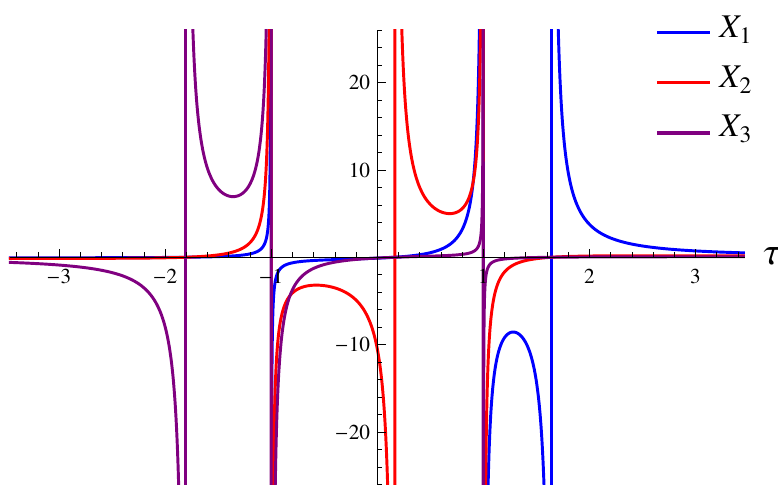
Figure 2. Behavior of the variables X i given by Equation (30) in general relativity. Each variable X i has a pole at respective τ = τ i . These are just special points of the solution, with all connection and metric components remaining finite. Furthermore, all variables X i have common poles at τ = ± 1. These are the singular points for both the connection and the metric. The region “between” two Kasner singularities describes a solution with negative Λ , while the two outer regions describe solutions with Λ >